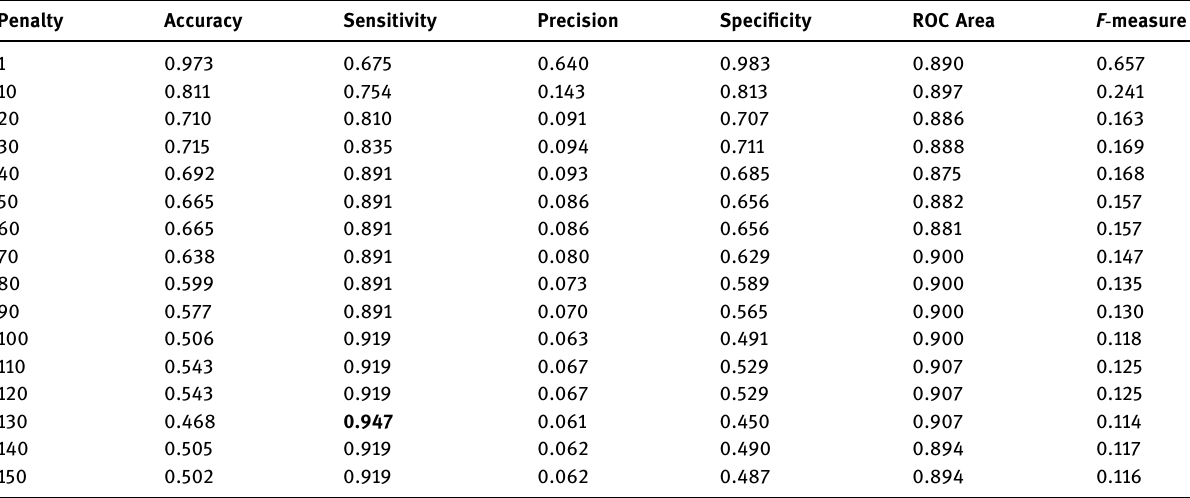
Table 6: Performance of combing AdaBoost and cost - sensitive methods